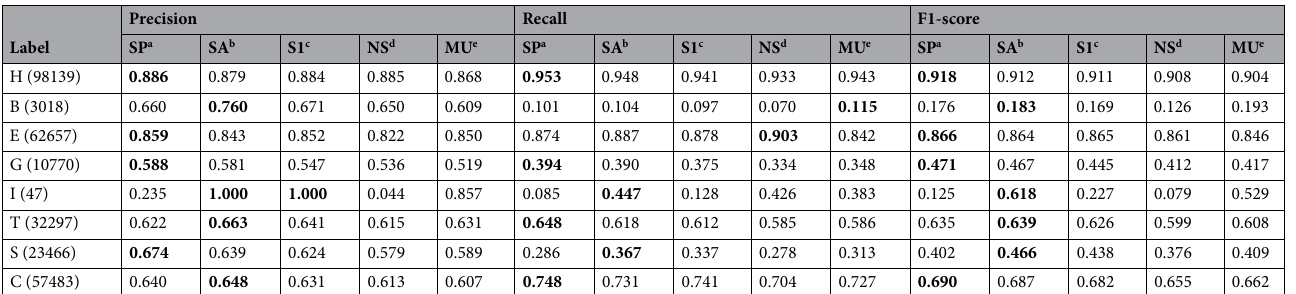
Table 2. Precision, recall, and F1-score for individual secondary structure states obtained from the TEST2016 dataset. The numbers in parentheses represent frequencies of the secondary structure states. The data from all other methods except S-Pred were obtained from Uddin et al. 11 . The method that performs the best is represented in bold. a S-Pred (SP). b SAINT (SA). c SPOT-1D (S1). d NetSurfP-2.0 (NS). e MUFOLD-SS (MU).